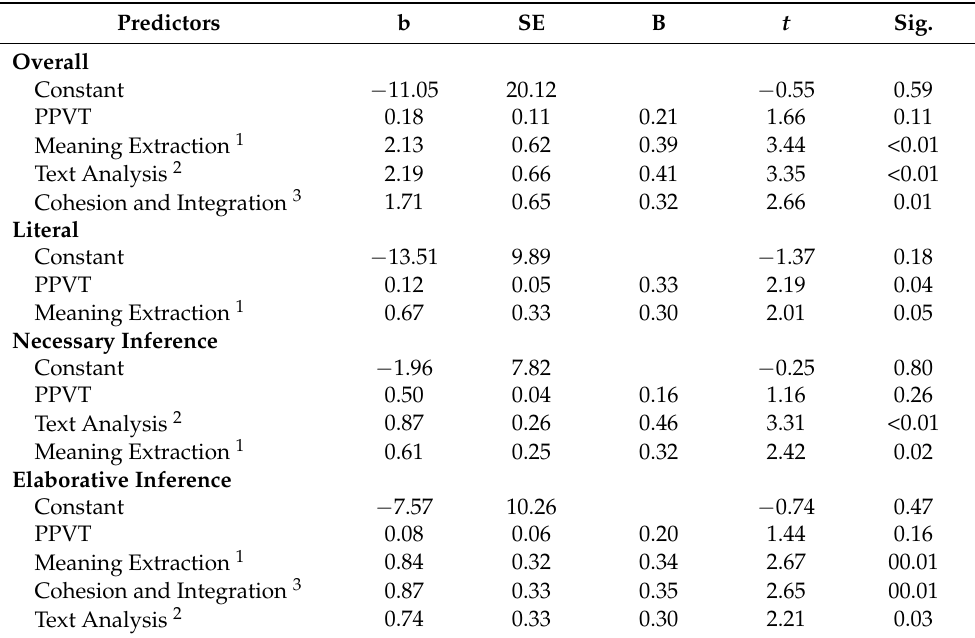
Table 6. Coefficient Table of English Variables That Predict Successful English Reading Comprehension. Predictors b SE